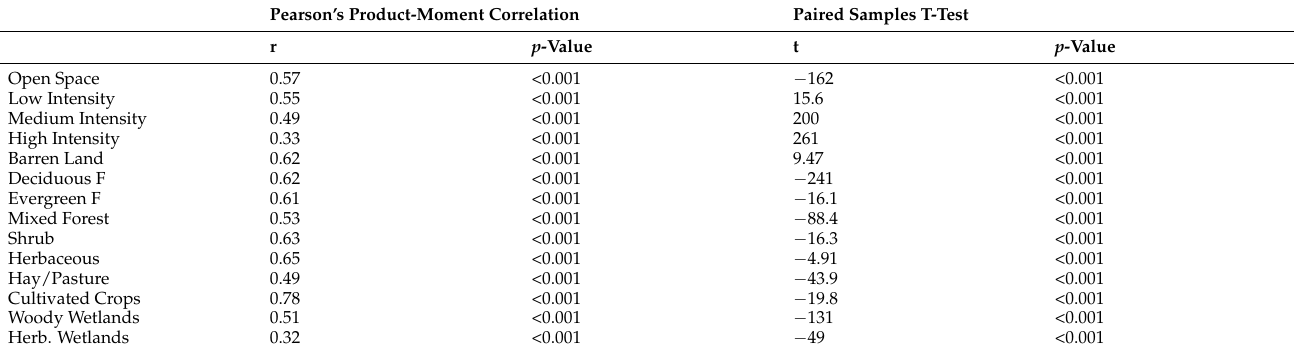
Table 6. Statistics for Washington,